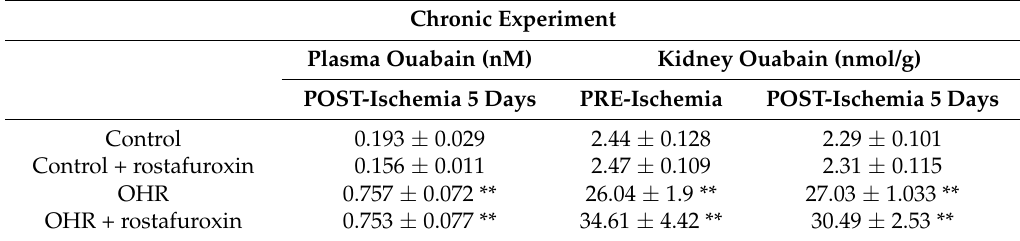
Table 2. Plasma and kidney ouabain content of rats from the chronic